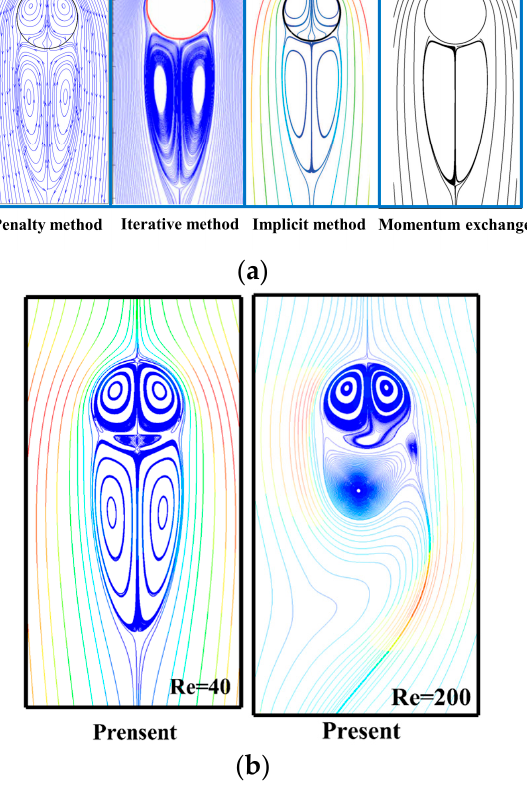
Figure 6. Streamline diagrams: ( a ) four popular method results when Re = 40; ( b ) result of present method when Re = 40 and 200.